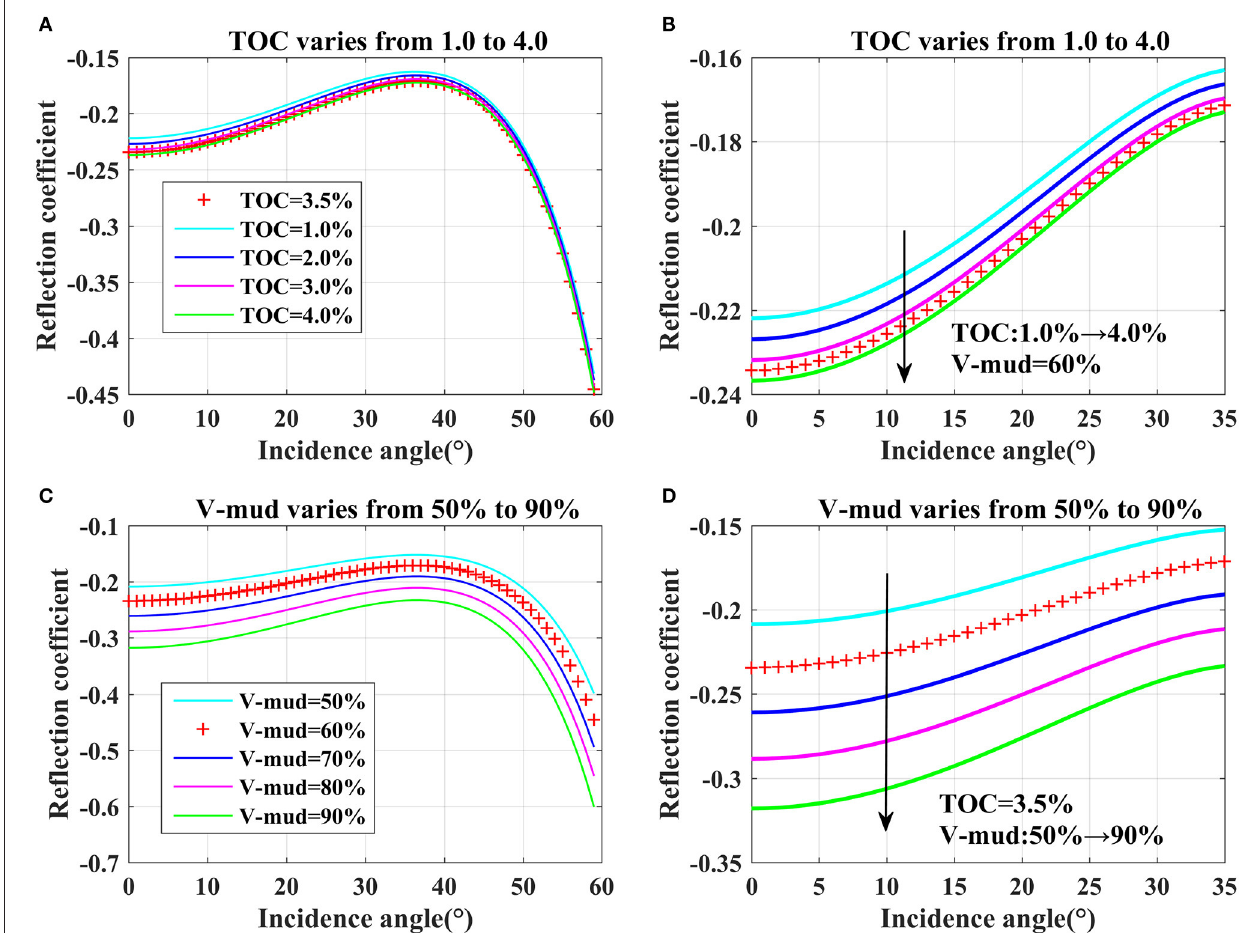
FIGURE 15 | The PP-reflection coefficients vary with incident angle (denoted as θ ) for different TOC content and mud content. (A) TOC content increases from 1.0 to 4.0%, θ is 0–60 ◦ , (B) TOC content increase from 1.0 to 4.0%, θ is 0–35 ◦ , (C) mud content increase from 50 to 90 %, θ is 0–60 ◦ , (D) mud content increases from 50% to 90%, θ is 0–35 ◦ . (Red crosses represent the PP-reflection coefficients calculated by the average elastic properties of the actual well L3.).